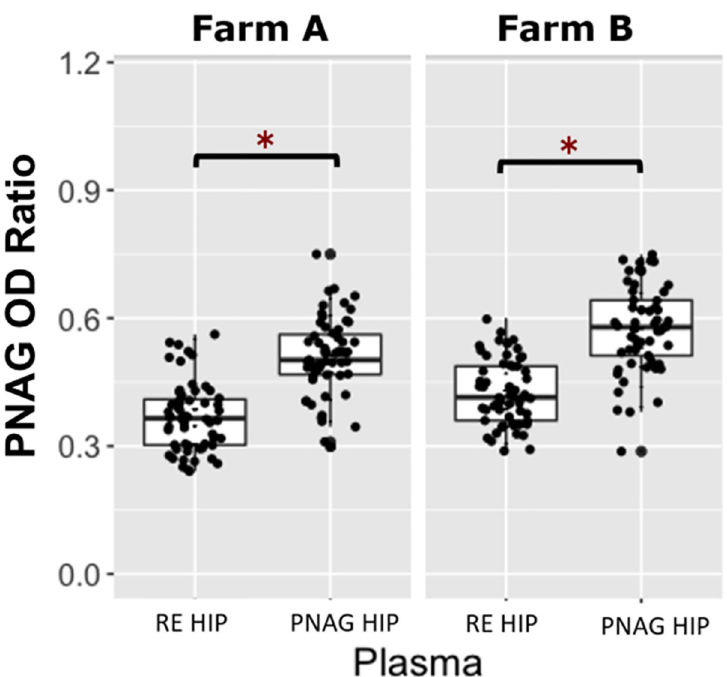
Fig 2. Comparison of PNAG optical density ratios between R . equi hyperimmune plasma and PNAG hyperimmune plasma. Boxplots of optical density (OD) ratios from ELISAs measuring deposition onto PNAG by serum antibodies in 119 foals from Farm A and 114 foals from Farm B, stratified by plasma type, faceted by farm. Foals transfused with PNAG hyperimmune plasma (PNAG HIP) at both farms had significantly higher (asterisks represent P < 0.05) OD ratios for PNAG than foals that were transfused with R . equi hyperimmune plasma (RE HIP). Statistical significance is indicated by asterisks. The mean (95% CI) OD ratio of anti-PNAG antibodies among foals at Farm A and B were 0.51 (0.49 to 0.53) and 0.58 (0.55 to 0.60), respectively among foals transfused with PNAG HIP and were 0.37 (0.35 to 0.39) and 0.43 (0.40 to 0.43), respectively, among foals transfused with PNAG